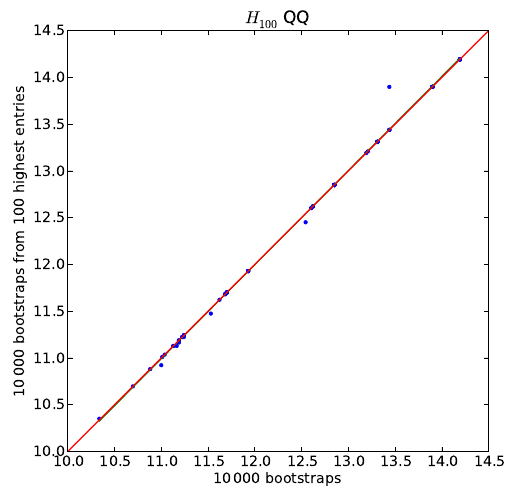
Figure 3. A quantile–quantile comparison of 10000 bootstrapped direct 100-year return estimates of significant wave height taken from a forecast ensemble (Breivik et al., 2013) versus a bootstrap from the upper 100 entries in the sample. The 45 ◦ line is shown in red.